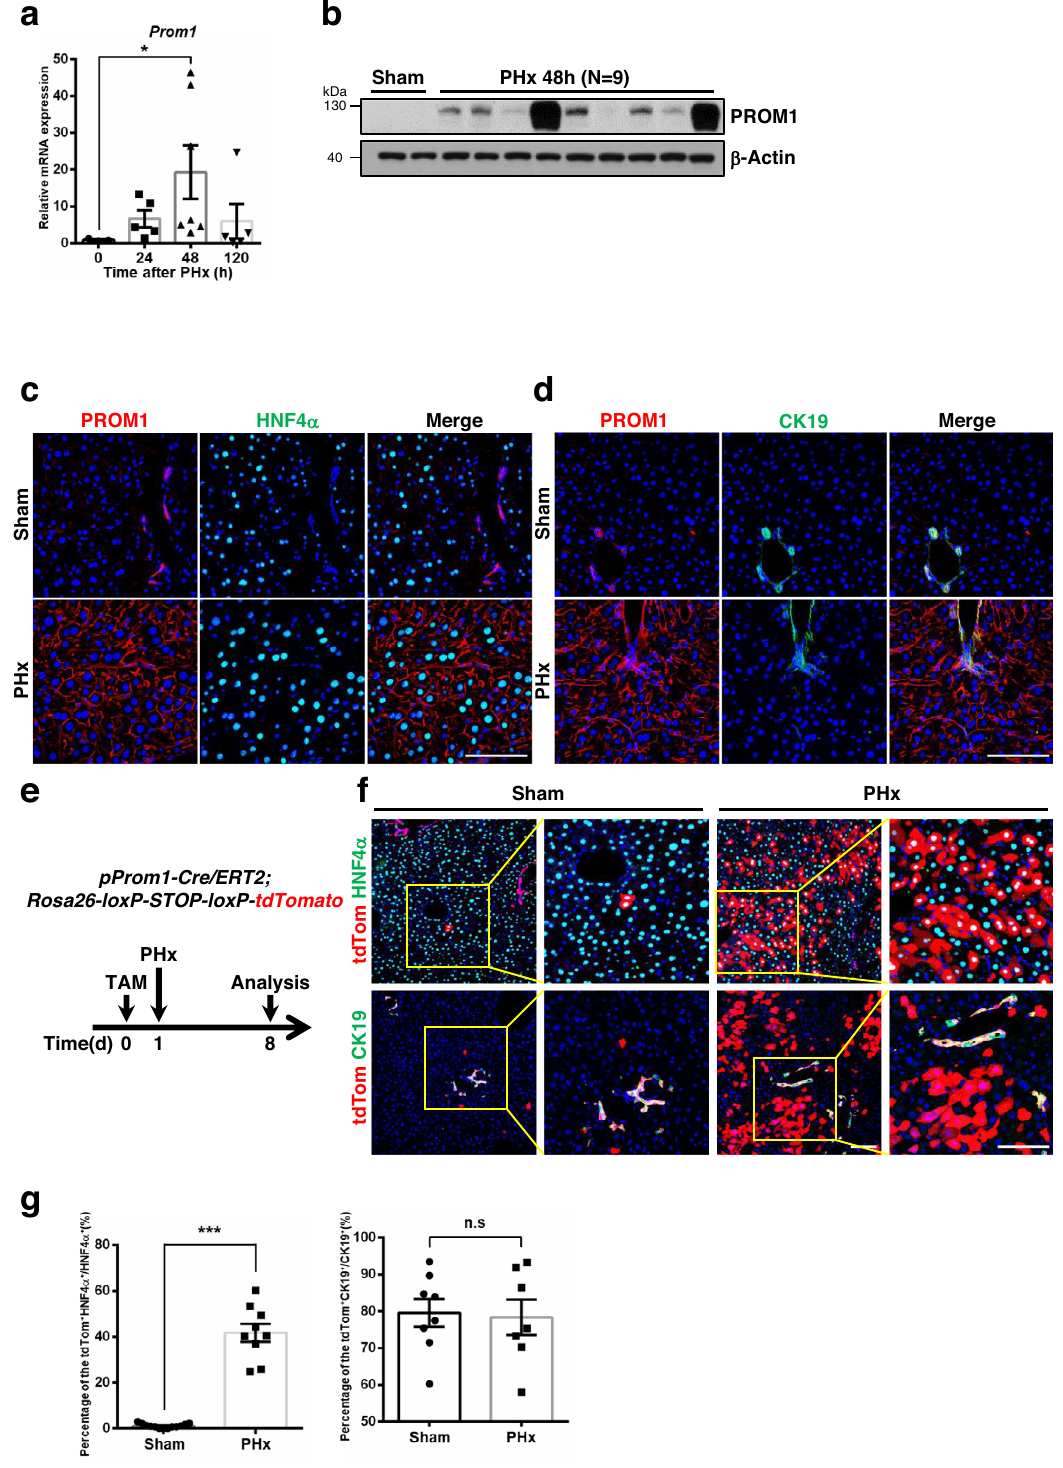
Fig. 1 | The expression of PROM1 in hepatocytes increases after partial hepa- tectomy. A 2/3 partial hepatectomy was performed in 8-week-old male wild-type mice. a The relative mRNA level of PROM1 in sham and PHx livers ( n =3 for sham, n =5 for 24h, n =7 for 48h, n =5 for 120h, p =0.045). b Immunoblotting for PROM1 in wild-type livers 48hours after PHx ( n =2 for sham, n =9 for PHx). c , d Double immuno fl uorescence for PROM1 and HNF4 α ( c ) or CK19 ( d ) in sham andPHxlivers. e Prom1 Cre/ERT2 ;Rosa26 tdTomato miceweregeneratedforlineagetracing of cells expressing PROM1 in the liver. PHx was performed 1 day after tamoxifen